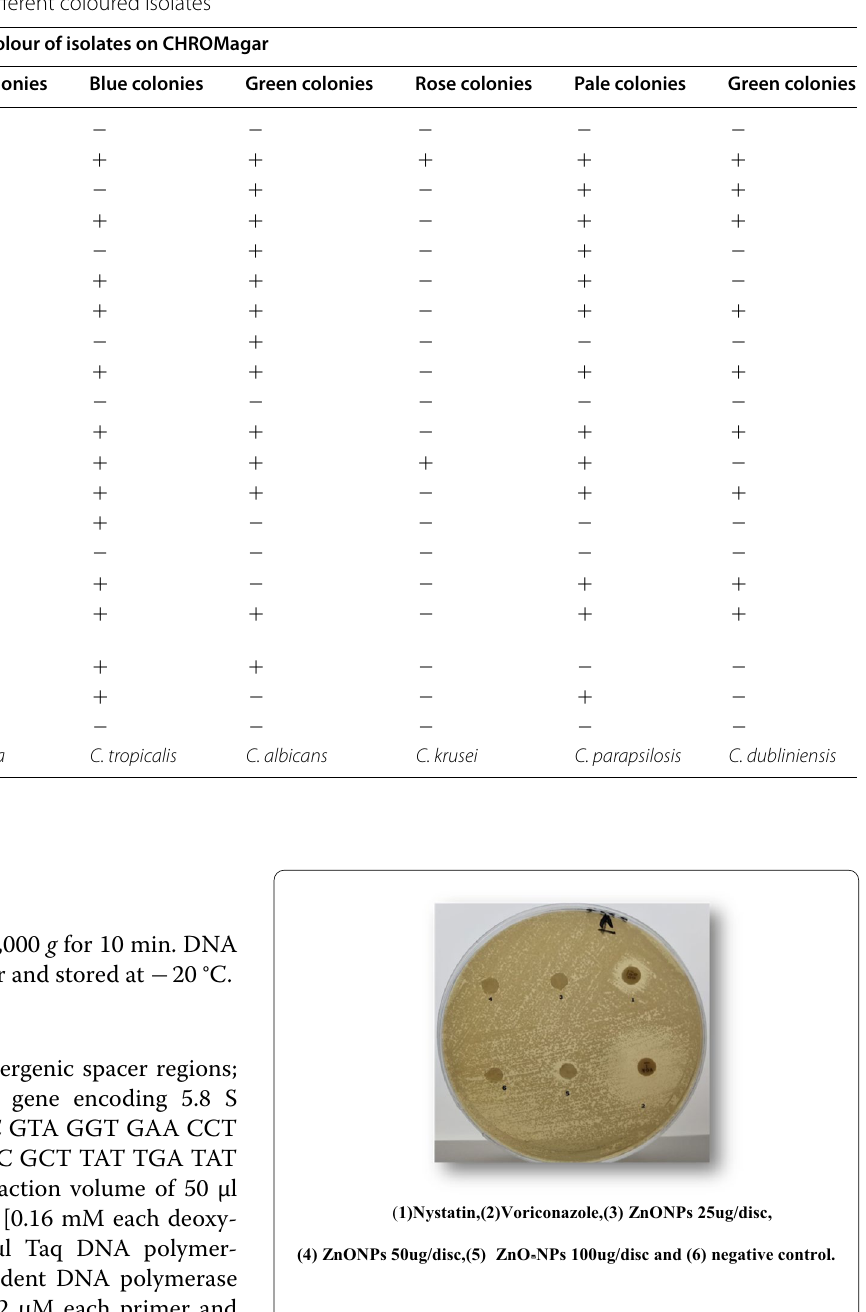
Table 2 API assay of some selected different coloured isolates Tests Colony colour of isolates on CHROMagar